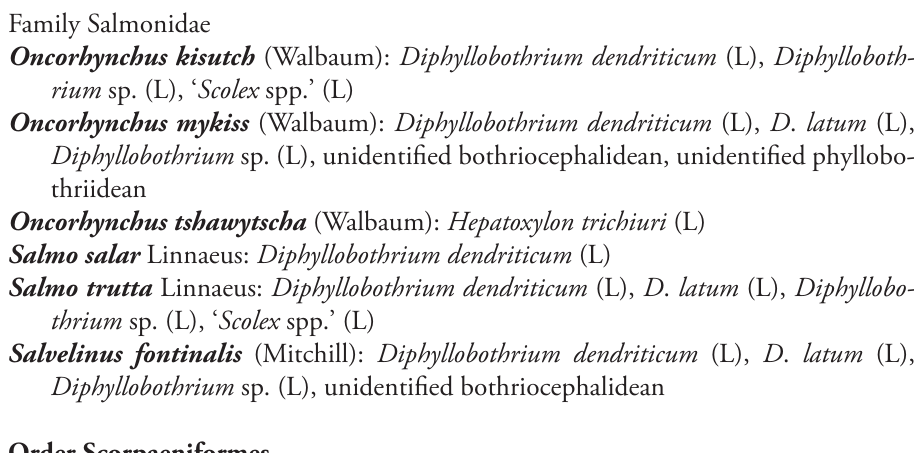
Order Salmoniformes